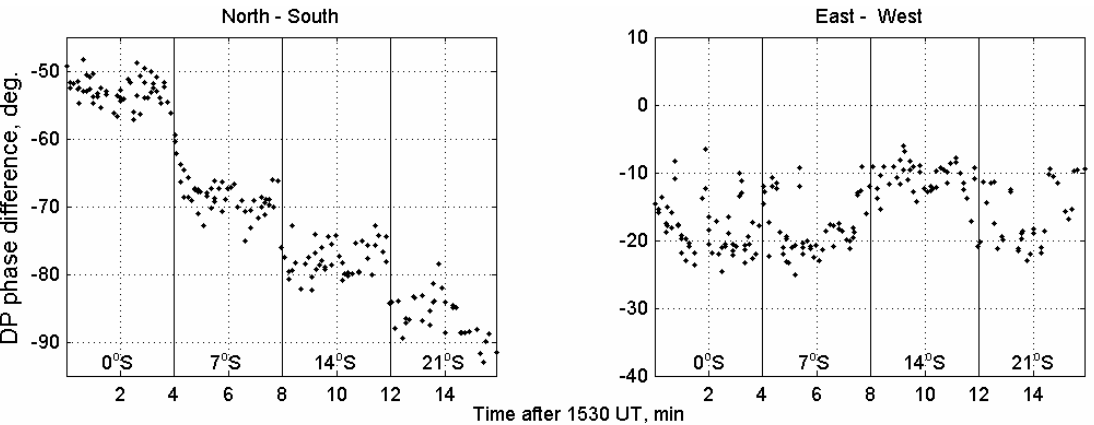
Fig. 7. Time variations of the phase difference (cross phase) of the SEE DP component for the two orthogonal antenna pairs. Vertical lines show the times of the HF beam position changes while the text indicates the angle of the HF beam. The time scale is in minutes from the initiation of pump modulation 1536-ms-on every 4s at 15:30